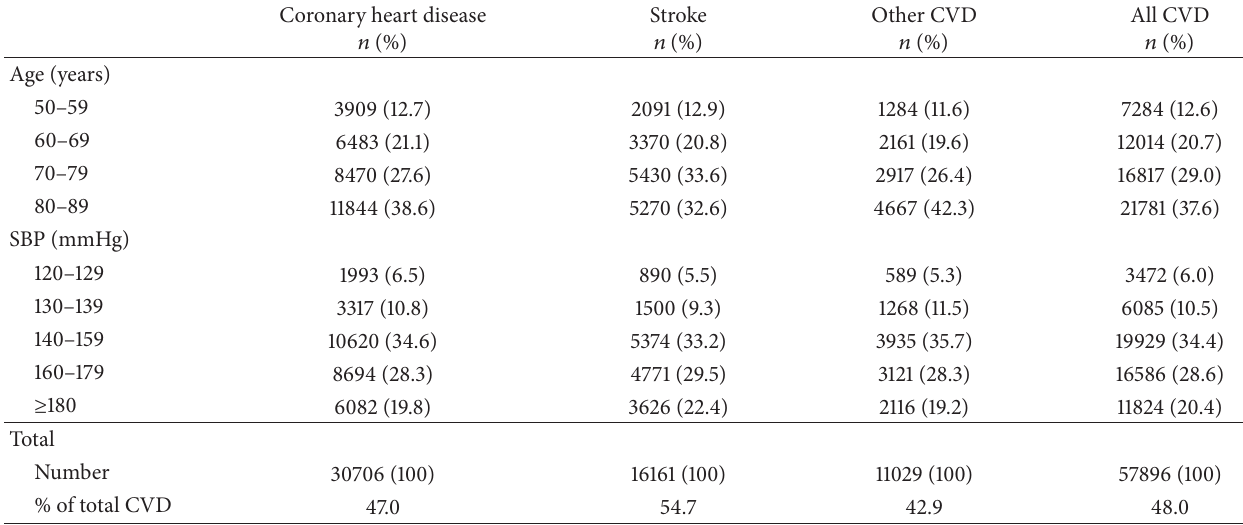
Figure 1: Percent mortality from all cardiovascular diseases attributable to higher-than-optimal systolic blood pressure in the population of Mexico aged 50 and over in 2010. The curve represents the smoothed distribution of systolic blood pressure (SBP) in the 2005-2006 Mexican sample based on SBP categories. The risk line represents the internationally-based relative risk values of cardiovascular mortality corresponding to each SBP category. The numbers at the heads of the bars indicate the percentages of all cardiovascular deaths occurred in Mexico in 2010 attributable to each category of SBP, by age. Table 3: Number and distribution of cardiovascular deaths attributable to above optimal systolic blood pressure (SBP), by age and SBP category in the population of Mexico aged 50 and over in